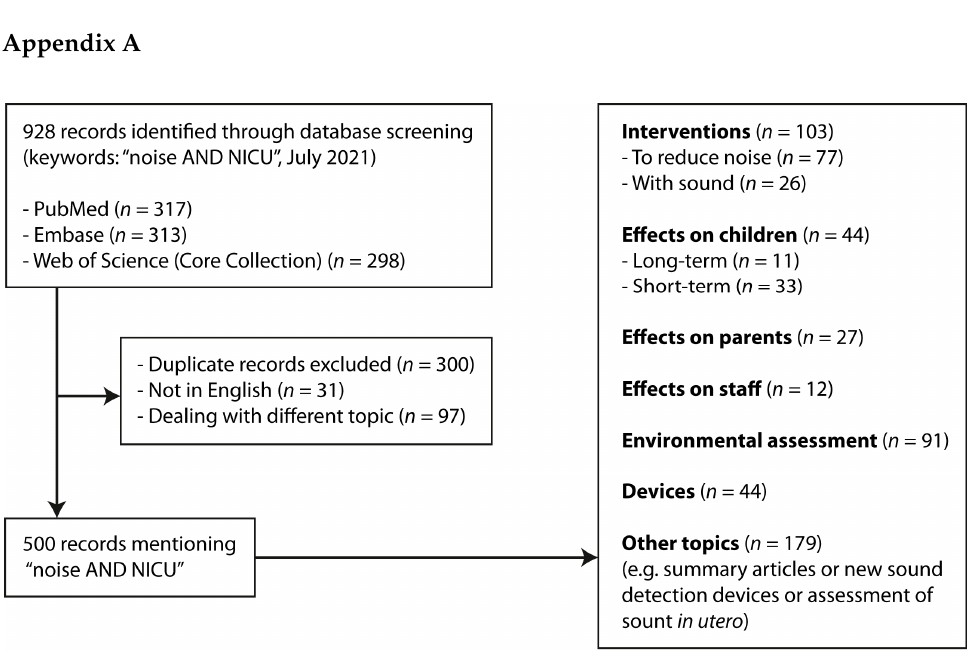
Figure A1. Literature review about “noise AND NICU” according to the PRISMA